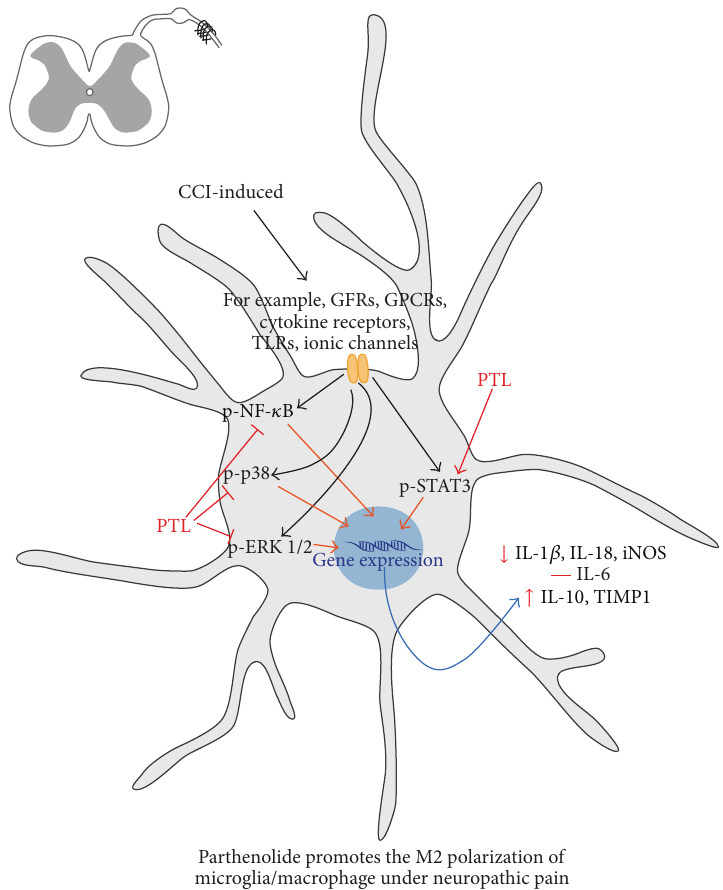
Figure 6: The possible influence of PTL on microglial/macrophage cell polarization. The extent of neuroinflammation observed under neuropathic pain depends on the bidirectional interactions between neurons and immune cells. As was suggested by many authors microglia/macrophages are among the main effector cells of the inflammatory response that takes place on the spinal cord level after injury [9, 42]. Therefore, it seems that targeting microglial signaling might lead to more effective treatment of neuropathic pain. In vitro evidence indicates that M1 microglia/macrophages can directly induce neuronal death [95, 96]. The activation of spinal microglia and infiltration of peripheral macrophages in the spinal cord can result in the release of both algesic (IL-1 𝛽 , IL-18, IL-6, and iNOS) and analgesic (IL-10 and TIMP1) mediators during neuropathic pain [42]. Polarization of microglia/macrophage can strongly influence nociceptive transmission in neurons [7, 97]. It is known that polarization of microglia/macrophage is divided into two phases: potentially neurotoxic M1, which is characterized by pronociceptive factors, for example, IL-1 𝛽 , IL-18, IL-6, iNOS, and neuroprotective M2 state, which is associated with release of antinociceptive markers, such as IL-10 and TIMP1 [12–15]. The results of our studies suggest that by direct or indirect mechanisms parthenolide promotes the M2 polarization of microglia/macrophage. In the present study, we have shown for the first time that chronic PTL treatmentpreventedtheupregulatedproteinlevelsofpronociceptiveIL-1 𝛽 ,IL-18,iNOS,andalsopotentiatedantinociceptiveIL-10andTIMP1 in CCI-exposed rats. Simultaneously, PTL affects directly and/or indirectly intracellular pathways, which play a key role in regulating the immune response: NF- 𝜅 B, p38, ERK1/2, and STAT3. PTL induced reduction of NF- 𝜅 B, p38, ERK1/2, and potentiated STAT3 activation. These molecular actions of PTL might be responsible for its analgesic effects during neuropathy and need future investigation. (PTL: parthenolide, IL: interleukin, iNOS: inducible nitric oxide synthase, TIMP: tissue inhibitor of metalloproteinases, NF- 𝜅 B: nuclear factor-kappa B, ERK1/2: extracellular signal-regulated kinase 1/2, STAT: signal transducers and activators of transcription, GFRs: growth factor receptors, GPCRs: G protein–coupled receptors, TLRs: Toll-like